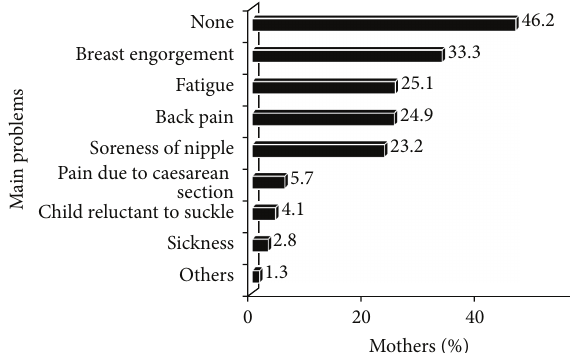
Figure 2: Main problems encountered during the breastfeeding